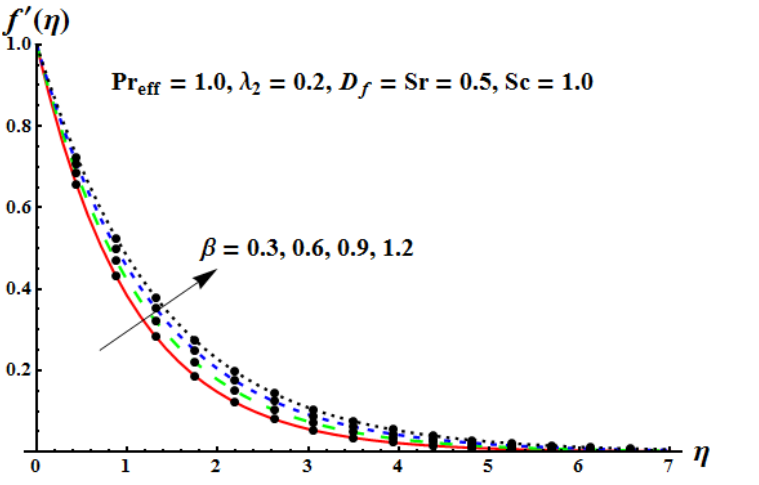
Figure 15. Influence of β on f (cid:48) ( η ) . Solid line: OHAM solution, solid circles: exact solution.